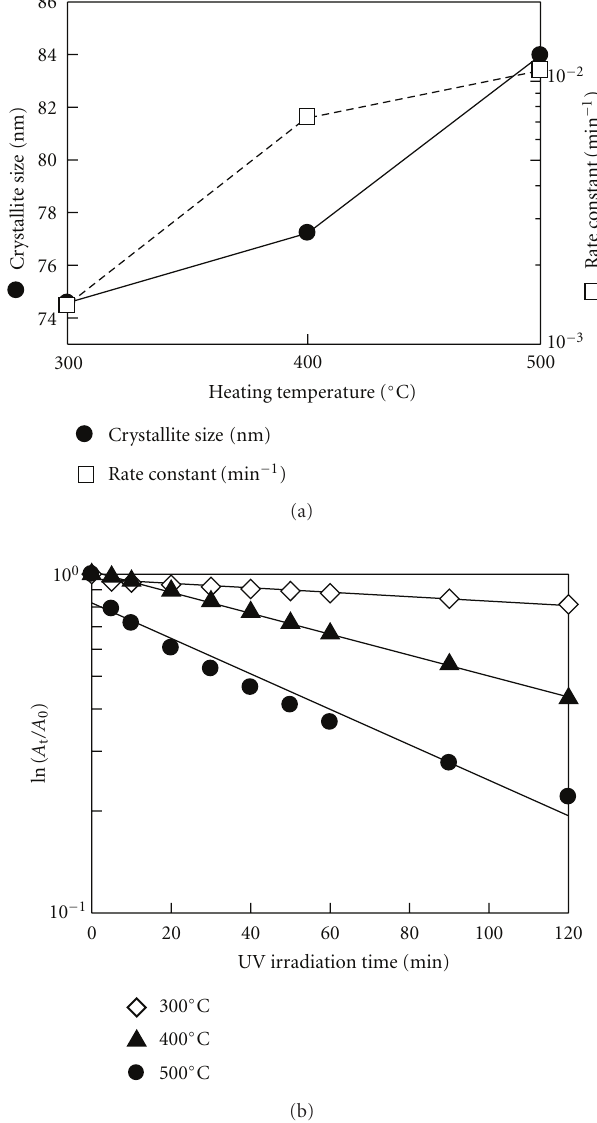
Figure 3: E ff ects of annealing temperature of the titania nanotube arrays (TNAs) anodized at 20V for 5h (a) on the crystallite size of (101) di ff raction peak and the rate constant, that is, the slope of (b), and (b) on the change of MB concentration as a ln( A t /A 0 ) (at 365nm) with ultra-violet irradiation